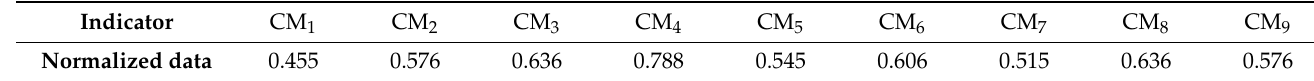
Table A15. Normalized data of construction management risk (CM).